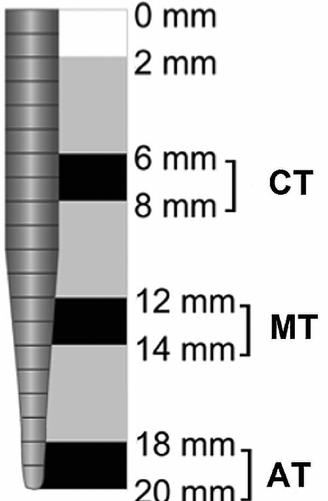
Figure 2. Schematic representation of the nº 1 White Post DC fiberglass post sections, where “CT” is the Cervical Third, “MT” is the Medium Third and “AT” is the Apical